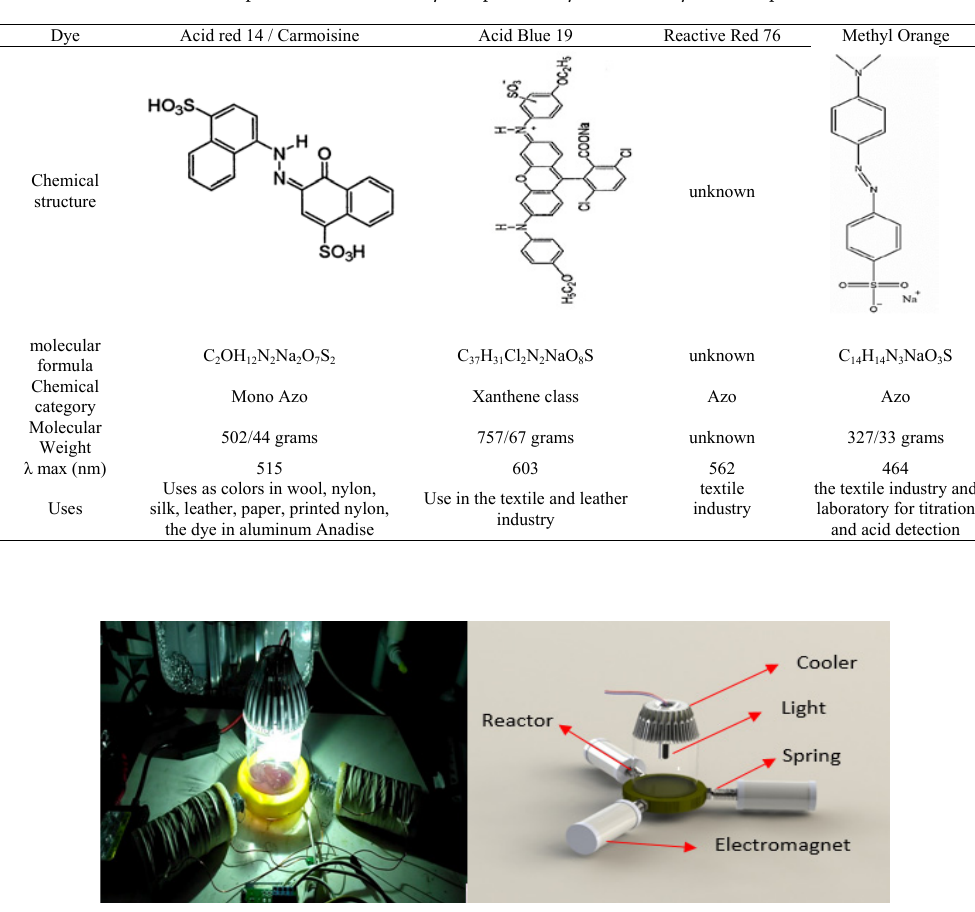
Table. 1. Specifications of tested dyes in photocatalytic removal by nanocomposites Table 1. Specifications of tested dyes in photocatalytic removal by nanocomposites